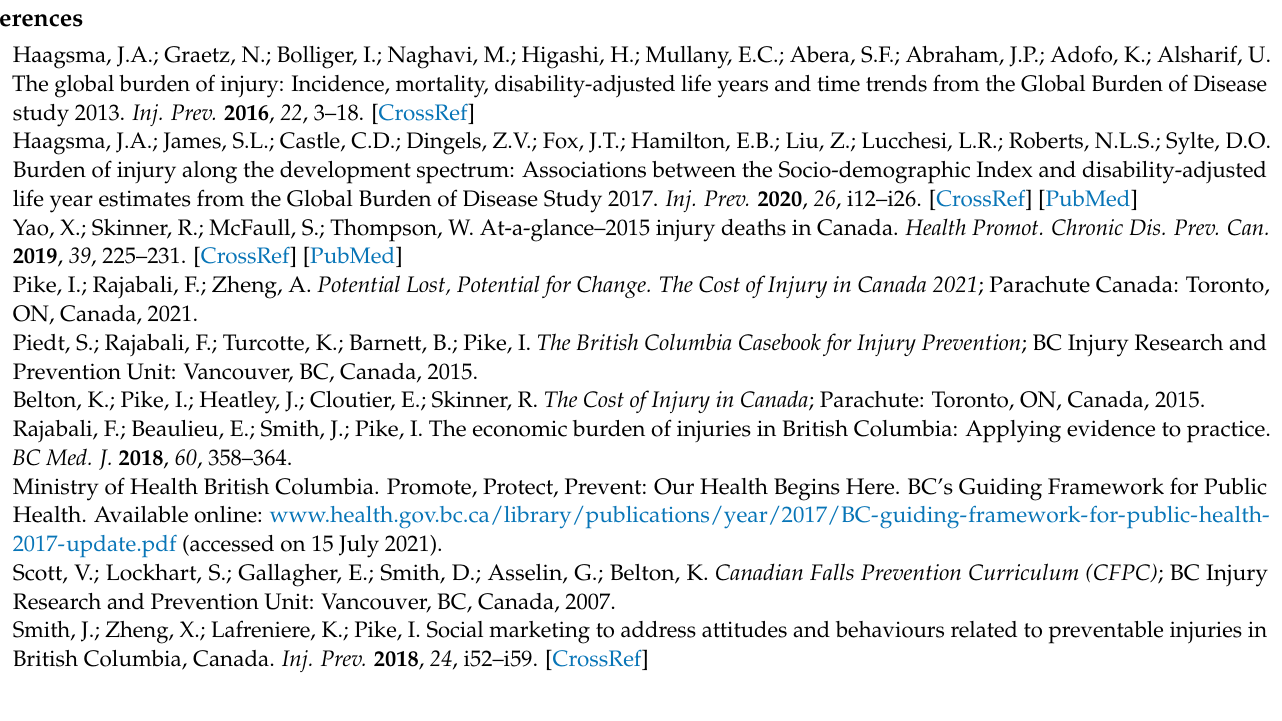
Table S2: Road Safety indicators after applying thresholds. Supplementary Table S3: Seniors Falls Indicators after applying thresholds. Supplementary Table S4: All-injury indicators after applying thresholds. Supplementary Table S5: Final Indicators, grouped by variations and disaggregations, with additional disaggregations included as part of the specification